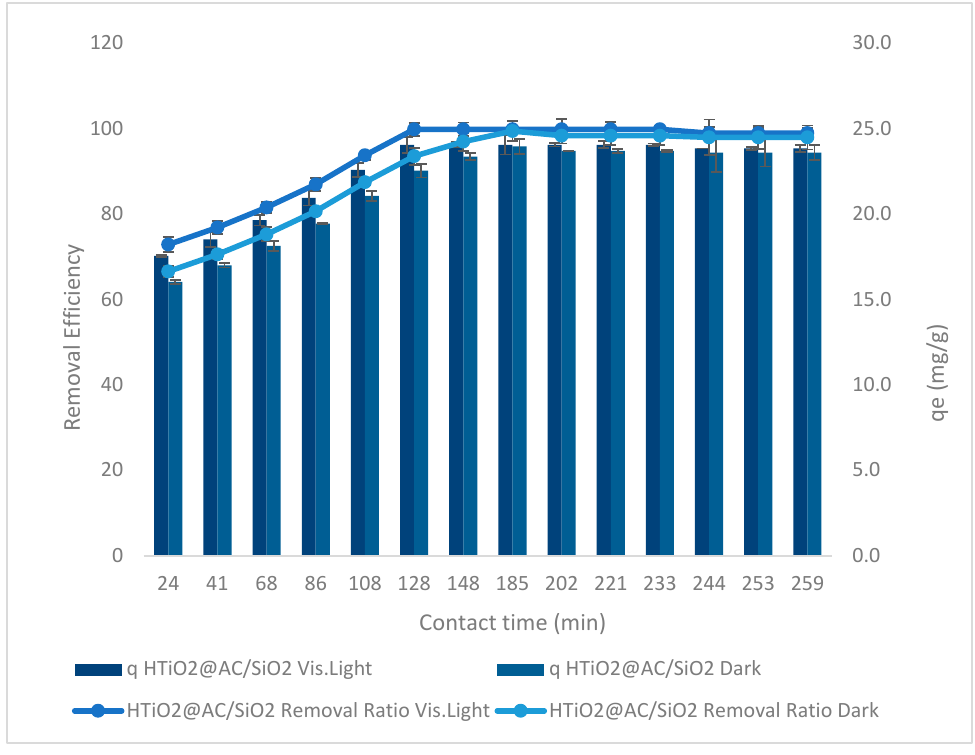
Figure 11. Contact time versus oxamyl removal effectiveness using HTiO 2 @AC/SiO 2 in visible light and in the dark.